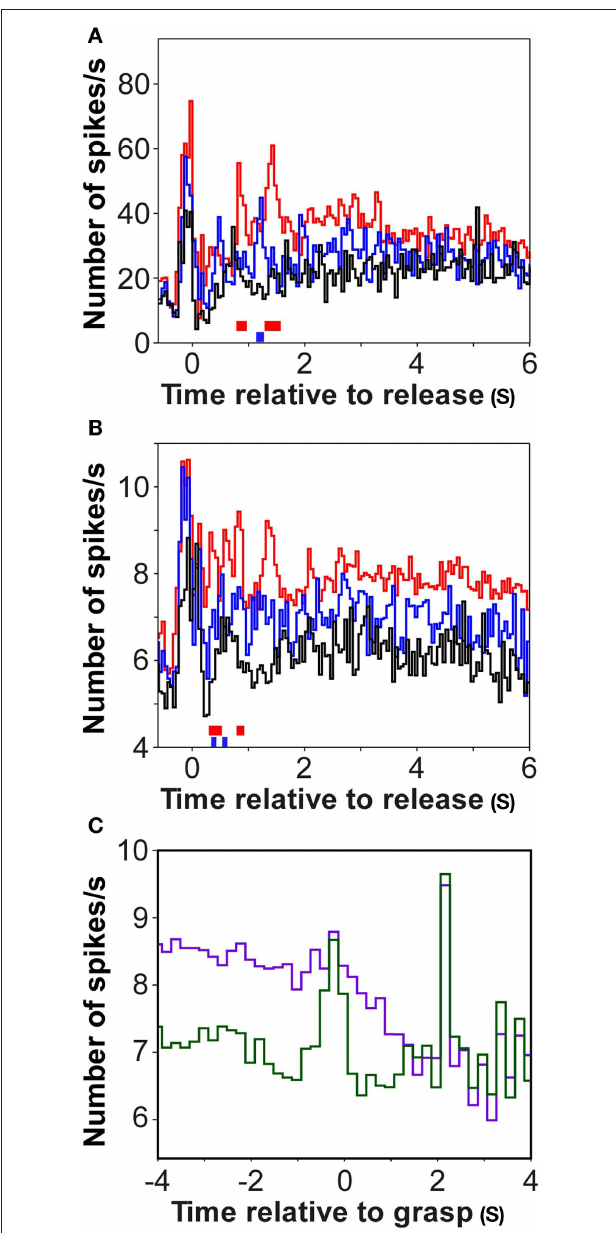
Figure 9 | reward-related firing of single units in auditory cortex. (A) Example of a single unit in auditory cortex whose firing distinguished the large (red) from the small (blue) and from the no-reward condition (black). Significant firing differences between conditions are indicated by colored bars at the base of the panels ( p < 0.001; bootstrap; red: large vs. no; blue: large vs. small). Conventions as in Figure 2 . (B) Average population response of 74 single units in auditory cortex relative to bar release. Note that only the reward response occurring early after bar release was significantly different when the large reward condition was compared to the small or the no-reward condition ( p < 0.001; bootstrap). By contrast, the response late after bar release was not significantly different ( p > 0.05; bootstrap), either for the three reward conditions or for different sizes of reward mismatch. (C) Population response of 74 single units in auditory cortex relative to bar grasping, revealing no significant difference ( p > 0.05; bootstrap) between the firing when the monkeys expected a large (green) or a small reward (blue) in a